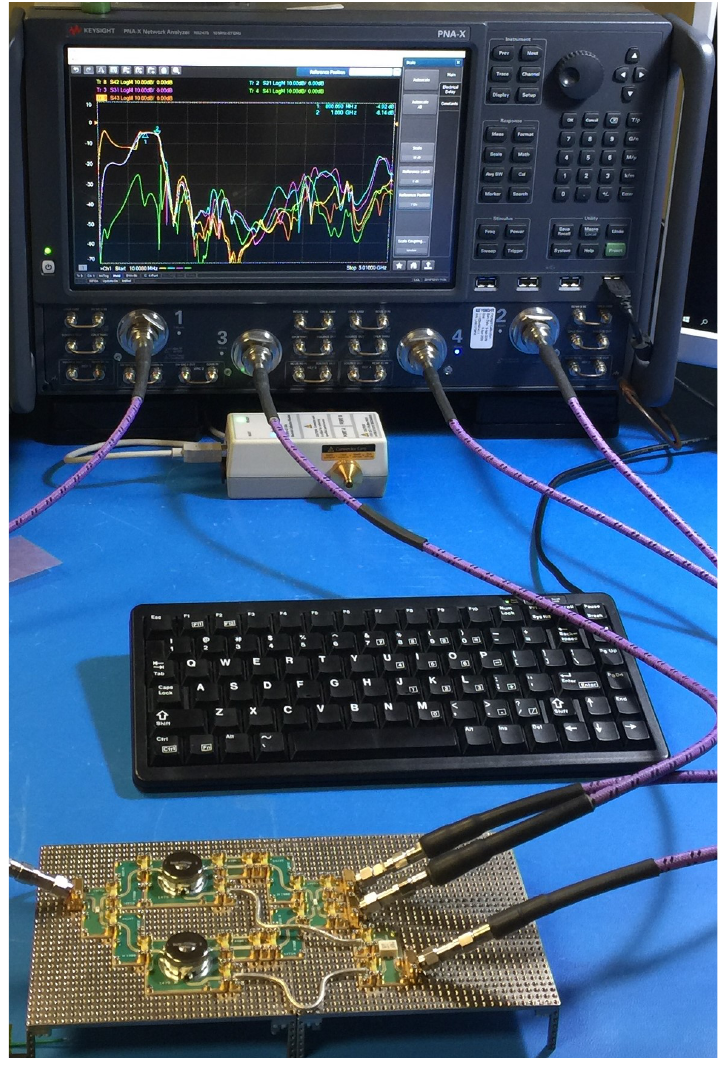
Figure 12. Characterization set-up with the VNA in place.